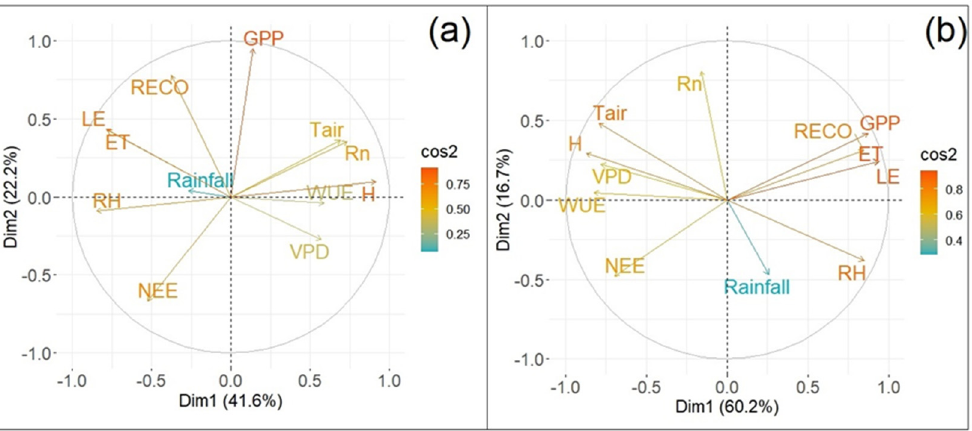
Figure 5. Principal component analysis (PCA) biplots for the ( a ) dry season and ( b ) wet season, showing the dependency between meteorological and carbon variables. Vertical and horizontal coordinates represent the correlation between variables and principal components 1 (Dim1) and 2 (Dim2), respectively. The proportional representativeness of each variable in each component is shown by the colors associated with the cos2 value.